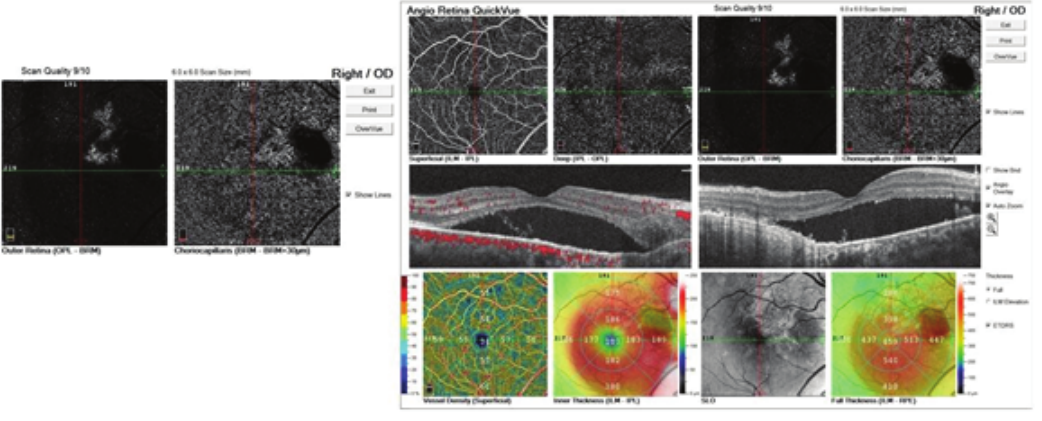
Figure 4. OCTA images of the right eyes illustrate high-flow vessels above the RPE in the outer retina as well as in the